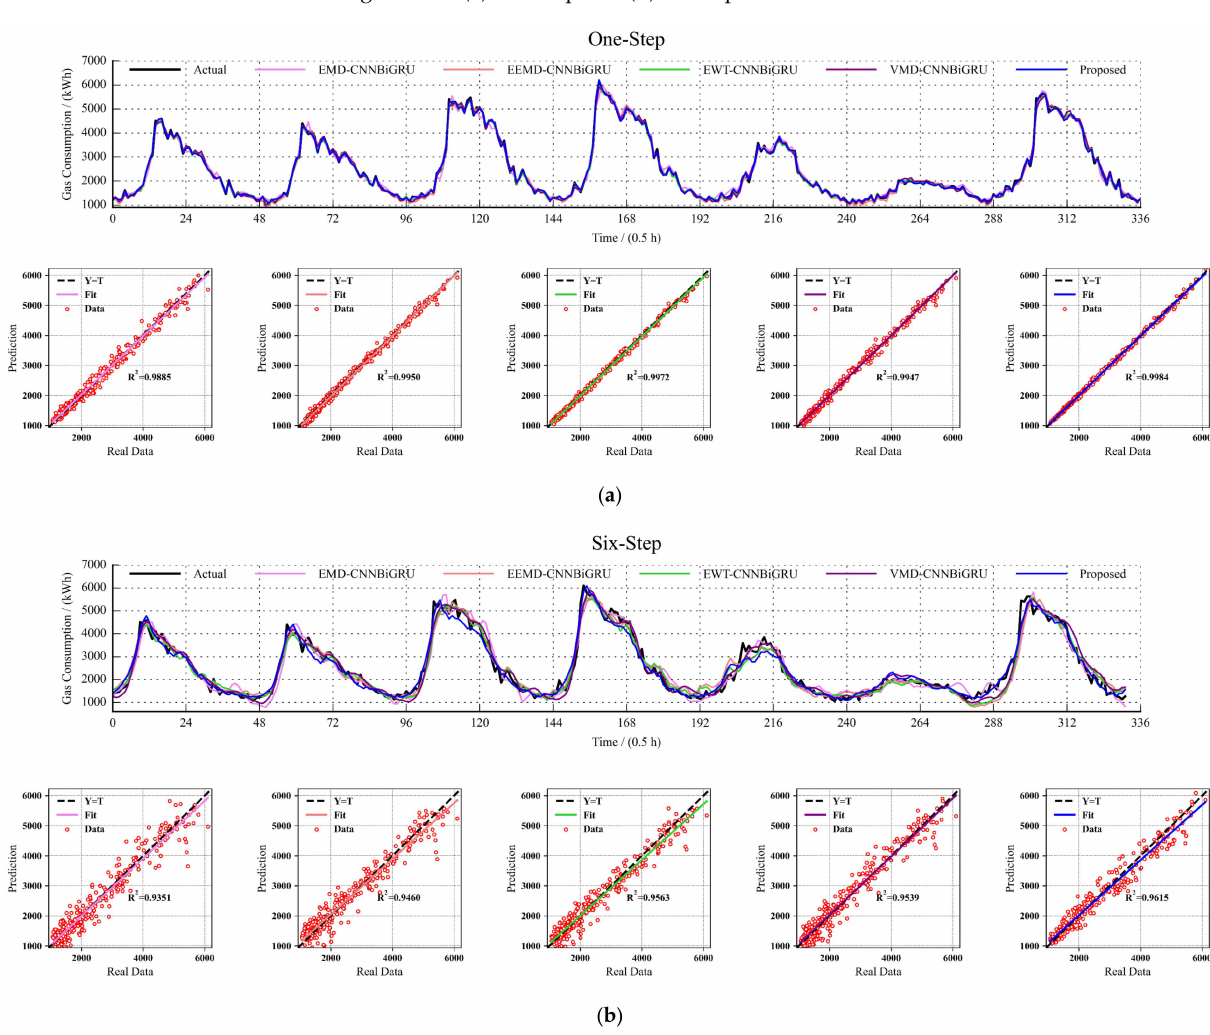
Figure 11. Multi-step ahead building gas consumption prediction results for different decomposition algorithms: ( a ) one-step and ( b )